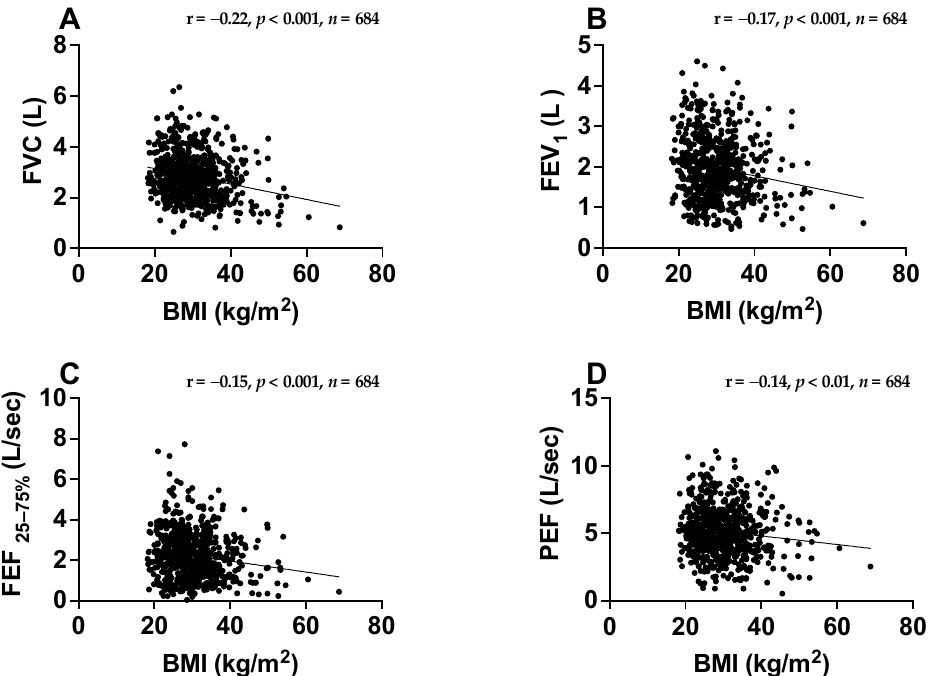
Figure 2. Correlation between body mass index (BMI) and spirometry values among patients with asthma. Correlations between BMI kg/m 2 with forced vital capacity (FVC) L ( A ), forced expiratory volume in one second (FEV 1 ) L ( B ), forced expiratory flow at 25% and 75% of the pulmonary volume (FEF 25–75% ) L/s ( C ) and peak expiratory flow (PEF) L/s ( D ) were as- sessed.